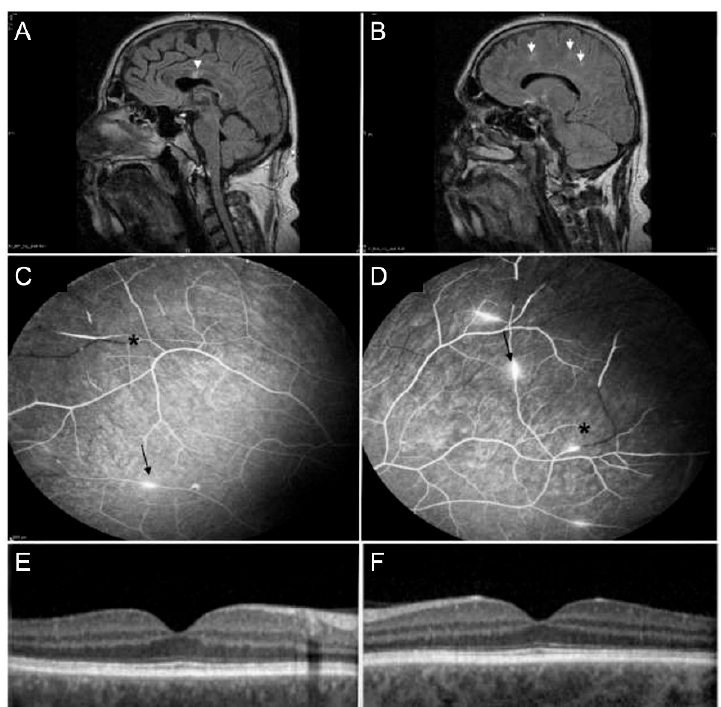
Figure 11. A 39-year-old man with Susac’s syndrome demonstrating hyperintense infarcts in the corpus callosum referred to as “snowball lesions” (white arrows, A ) and hyperintense lesions in the white matter (white arrows, B ) on T2 flair weighted magnetic resonance tomography (MRI) images. Ophthalmologic findings include multiple branch retinal artery occlusions (black asterisk) in the right ( C ) and left eye ( D ). In addition, there are areas of focal arterial wall hyperfluorescence (black arrow) on fluorescein angiography (FA) of both eyes ( C , D ). Optical coherence tomography (OCT) of both eyes (right eye: E , left eye: F ) is unremarkable.